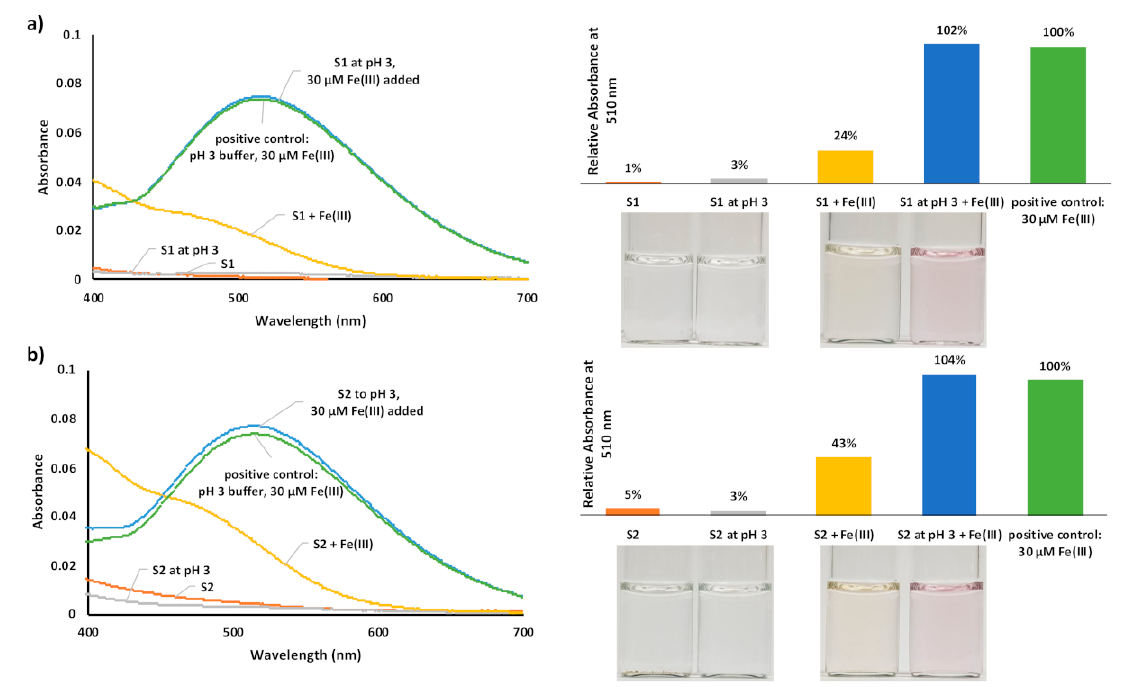
Figure 5. Evaluation of 2 in samples of ( a ) tap water (S1) and ( b ) stream water (S2). Samples are shown prior to and after acidification to pH 3. The spectra are shown to the left and the relative absorbance at 510 nm for each sample is shown in the bar charts to the right. The control samples were made up at pH 3 in an acetate